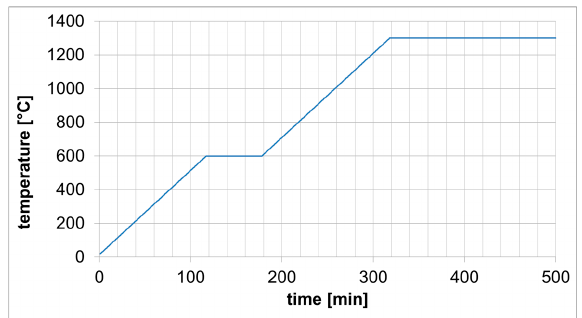
Figure 2. Sintering cycle for Catamold ® 17-4PH F.